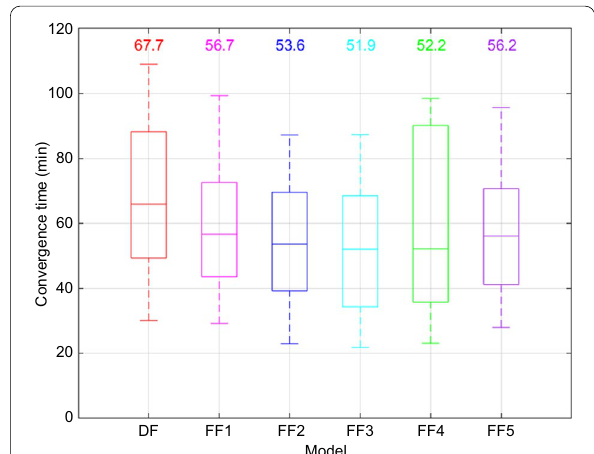
Fig. 16 Boxplot of the convergence time with different models for the selected 20